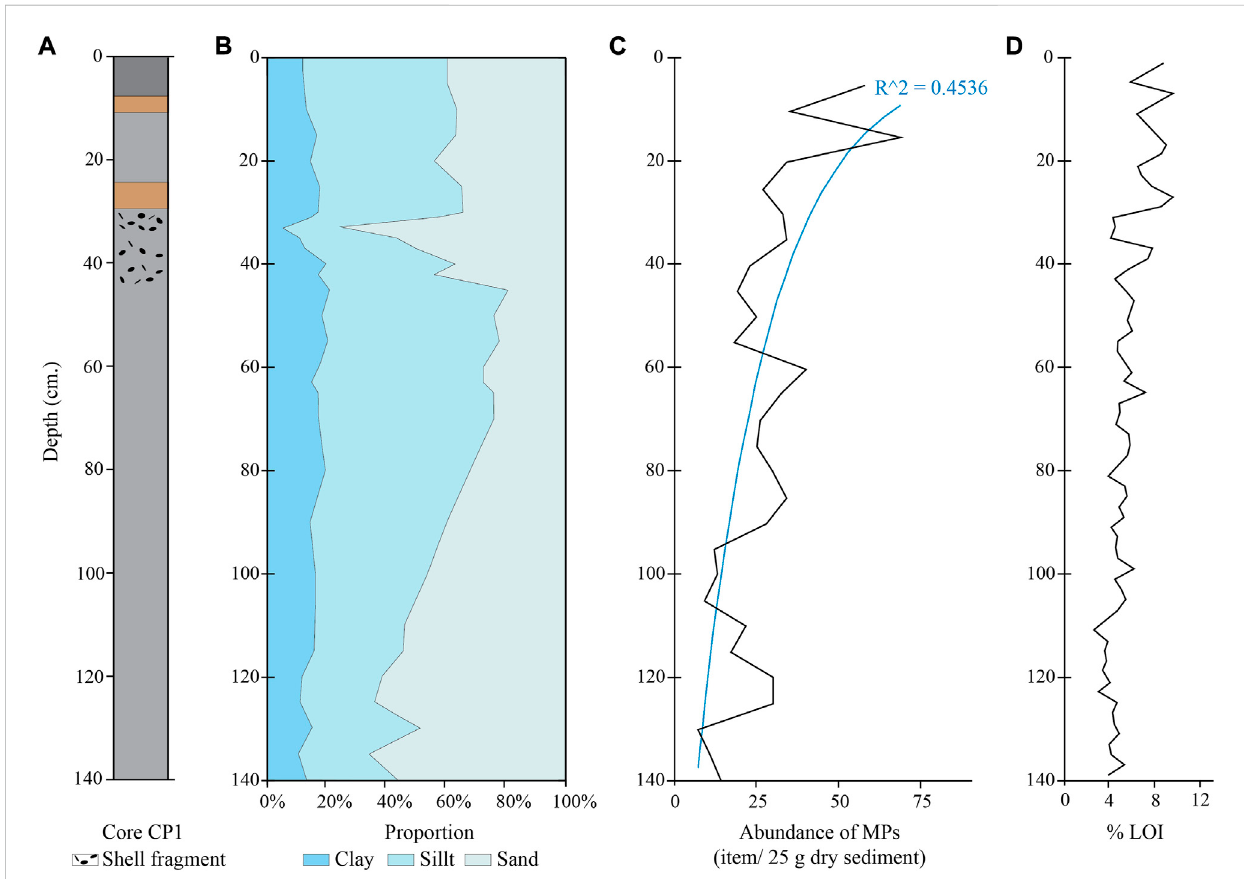
FIGURE 3 SedimentcoreCP1: (A) lithostratigraphyofcoreCP1; (B) percentageproportionsofthesizeofsedimentintheCP1core; (C) microplasticabundance in the CP1 core; (D) LOI percentage of sediment in the CP1